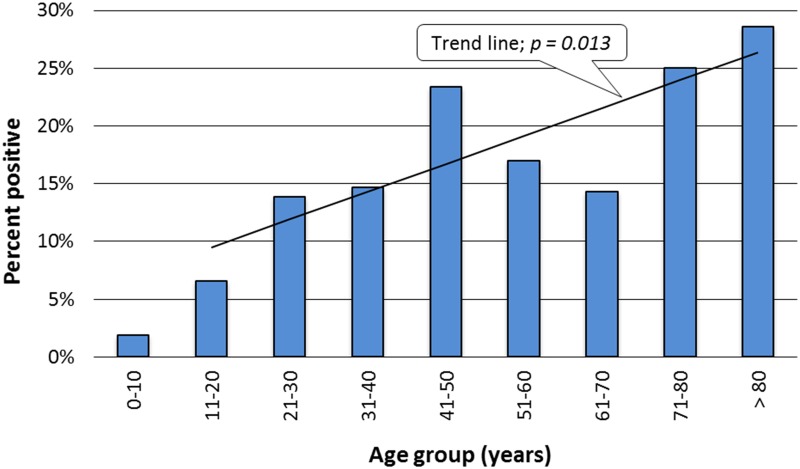
Prevalence of Rift Valley fever by age groups.The trend line indicates gradual increase of sero-positivity with age.